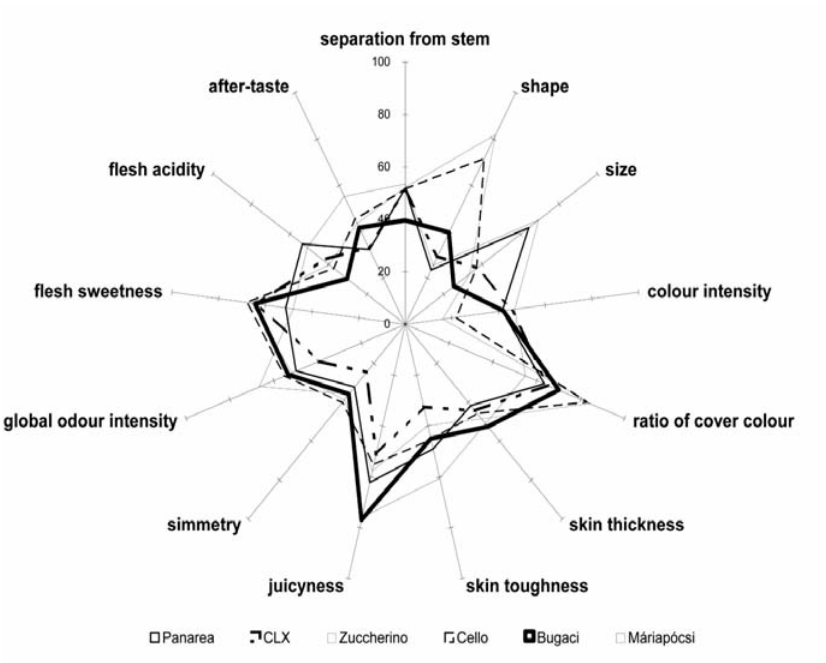
Fig. 1. Sensory profiles of examined tomato